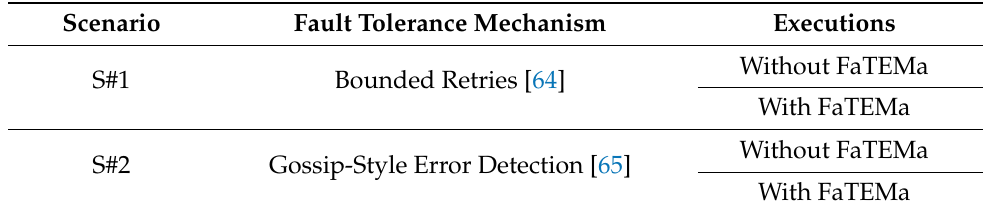
Table 3. Experimental scenarios and fault tolerance